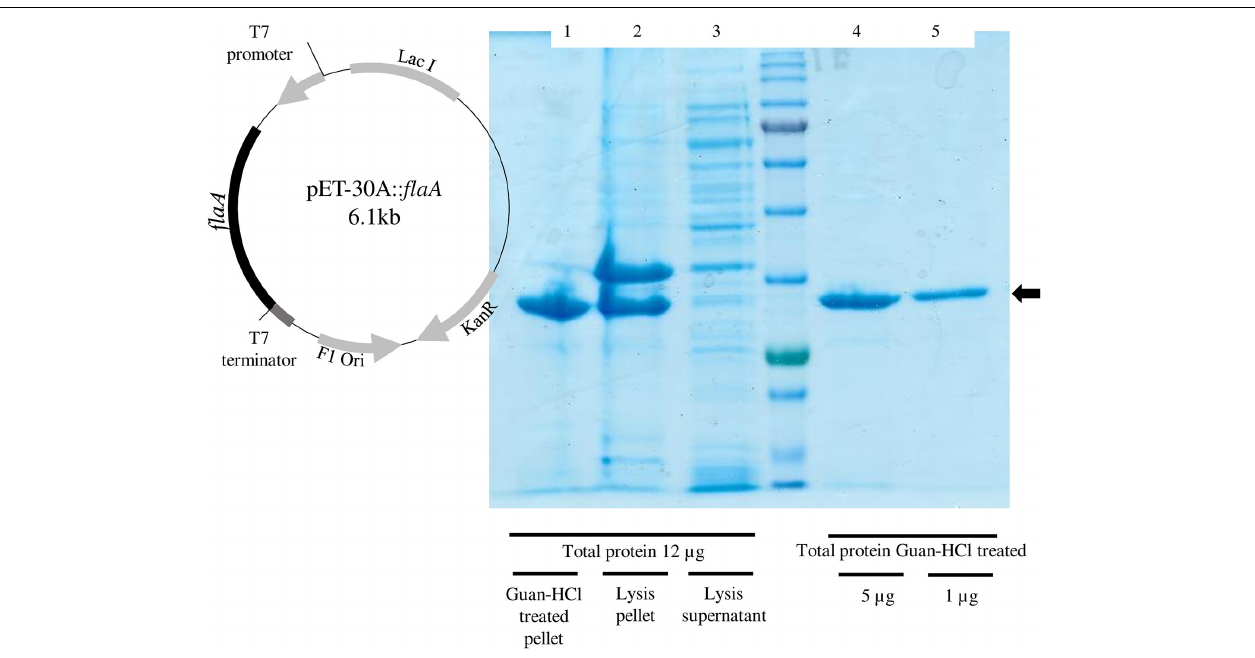
FIGURE 5 | Confirmation of FlaA expression and purification in Escherichia coli BL21. (Right) Graphical representation of recombinant plasmid pET-30A:: flaA. (Left) Denaturing electrophoresis with demonstration of flaA expression (black arrow). Lane 1—post lysis guanidine–HCl-treated fraction; lane 2—the post lysis-insoluble fraction; lane 3—post lysis-soluble fraction; all samples loaded are normalized with 12 µ g of total protein. In lanes 4 and 5 are, respectively, 5 and 2 µ g of total protein, post guanidine–HCl